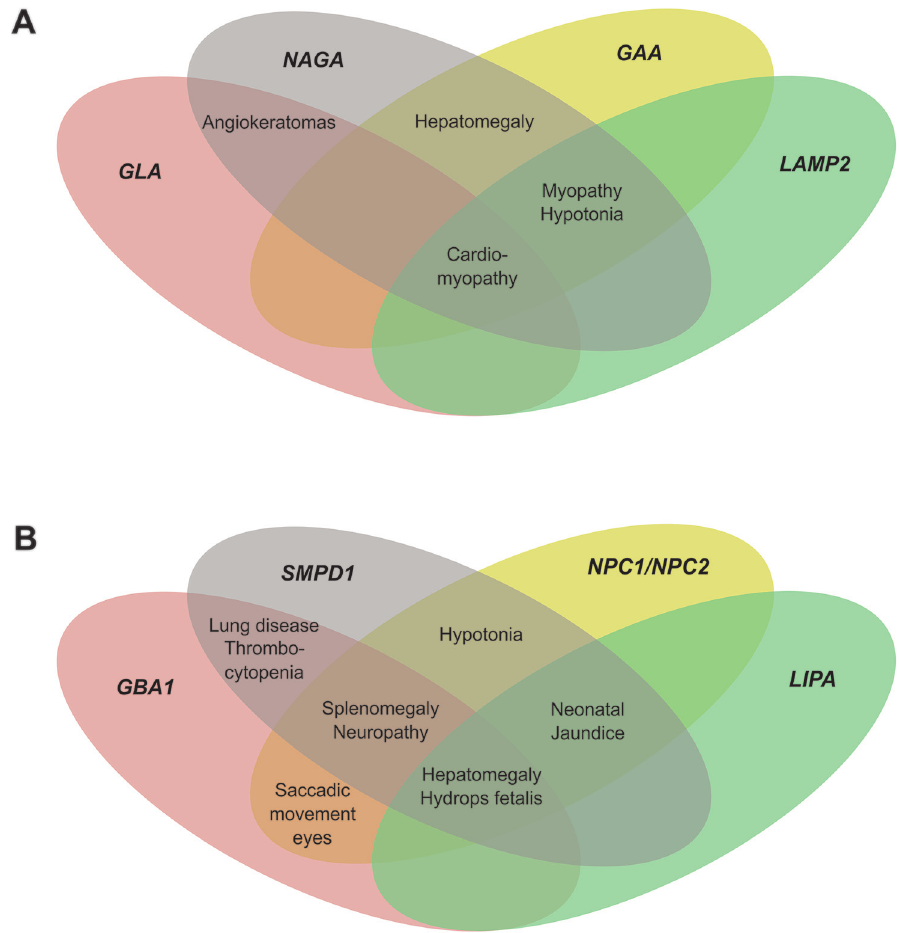
Figure 1 - Overlapping of clinical manifestations among LSDs. Venn’s four-set diagram represented by causal genes. A, Panel A. B, Panel